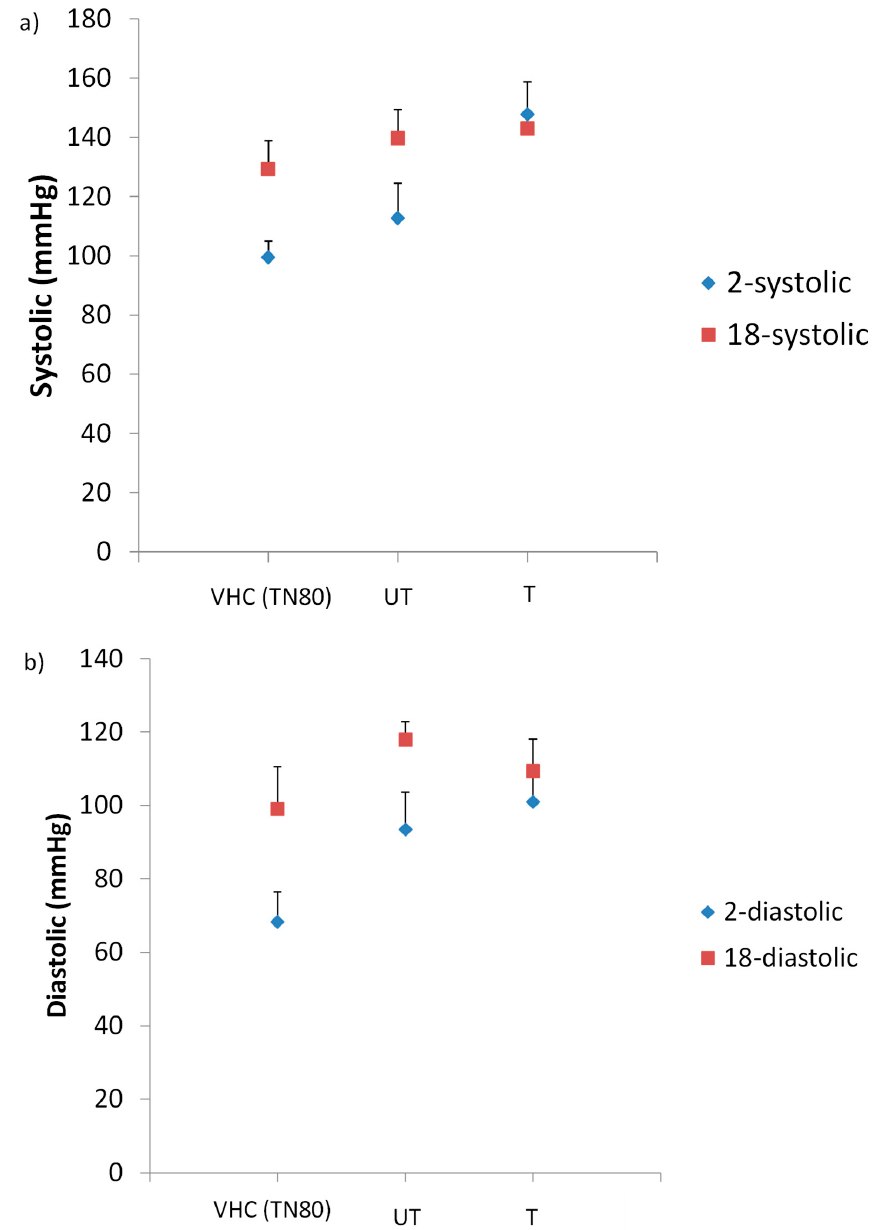
Figure 8. ( a ) Systolic and ( b ) diastolic blood pressure readings among treated rats. Data are expressed as means. (n ≥ 3 rats per group). 2-systolic / diastolic: diastolic BP reading on first week of treatment; as means. (n ≥ 3 rats per group). 2-systolic/diastolic: diastolic BP reading on first week of treatment; 18-systolic / diastolic: diastolic BP reading on third week of 18-systolic/diastolic: diastolic BP reading on third week of treatment.